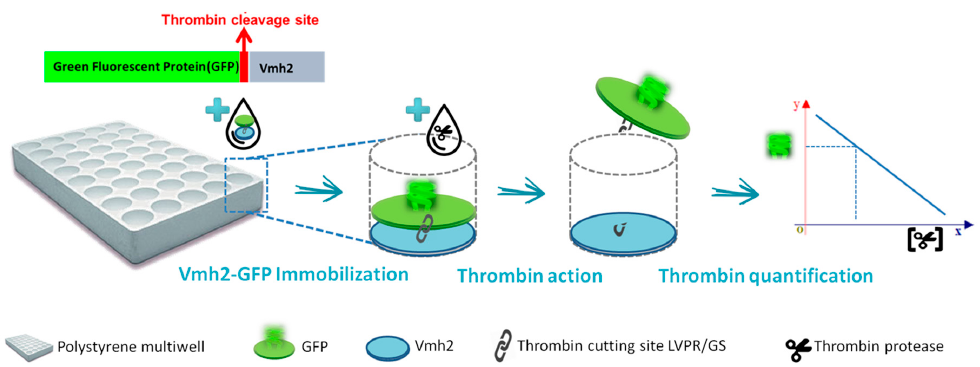
Figure 4. Thrombin biosensor developed on polystyrene multiwell plate coated with Vmh2-GFP fused proteins.